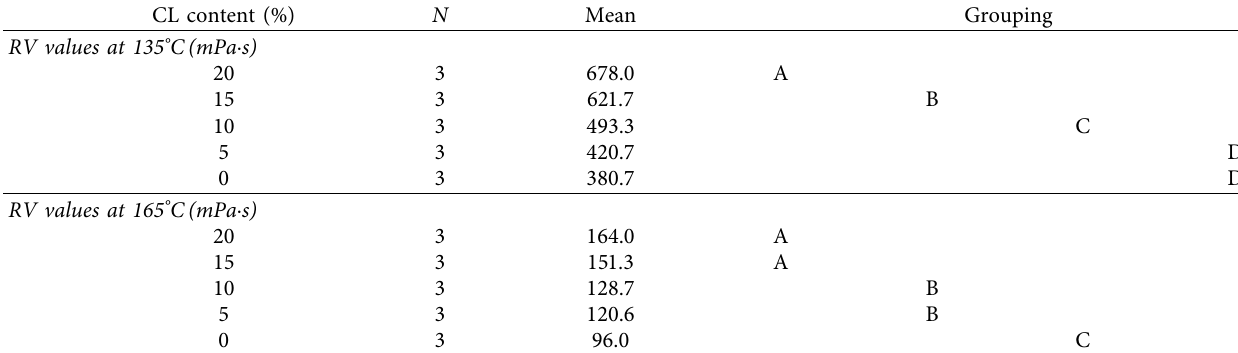
Table 6: Grouping information using the Tukey method and 95% confidence interval.